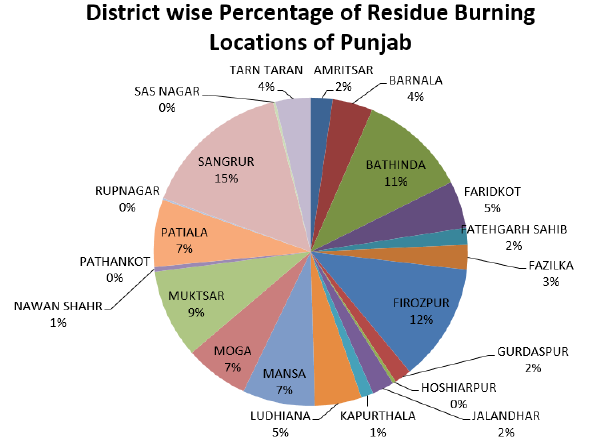
Figure 8.District wise fire counts percentage in Punjab